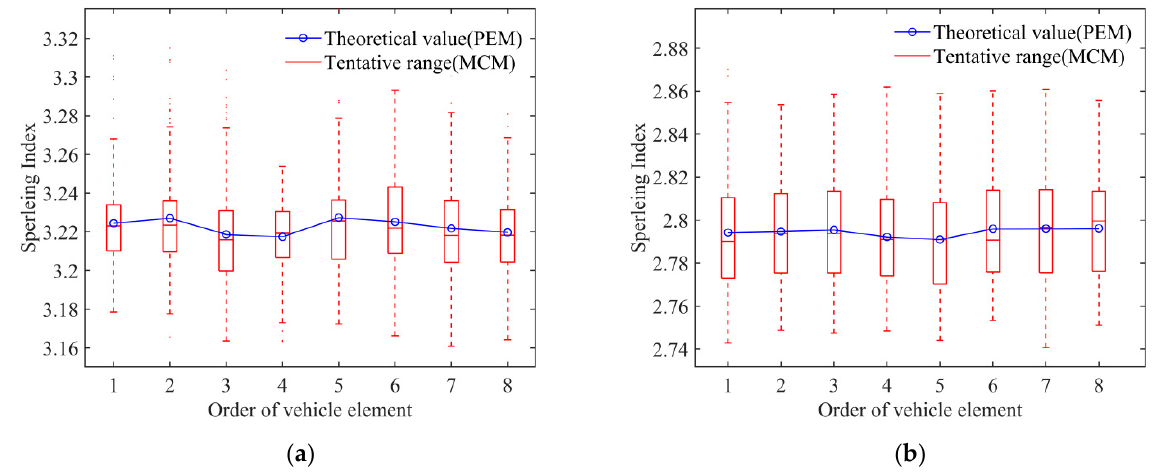
Figure 5. Car-body center Sperling index as the function of the order of vehicle element using MCM and PEM: ( a ) horizontal Sperling index; ( b ) vertical Sperling index.